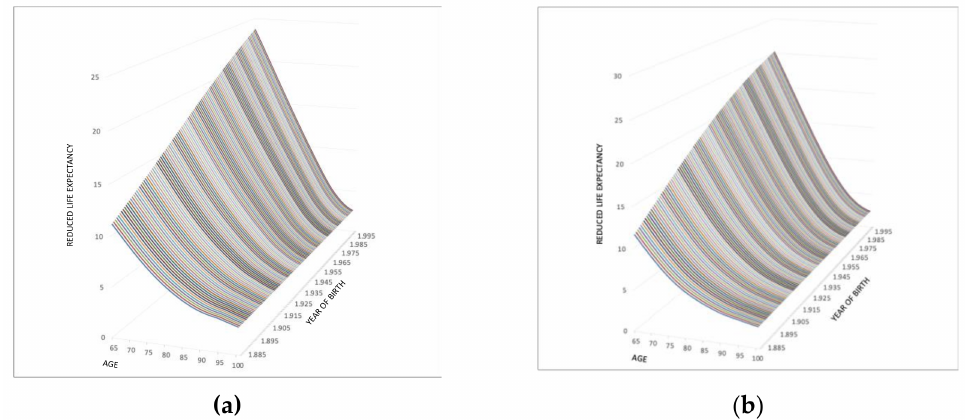
Figure 3. Reduction in the number of payments, according to the age of the severely dependent retiree by year of birth. Evolution by gender and age. ( a ) Men; ( b ) Women. Source: Own